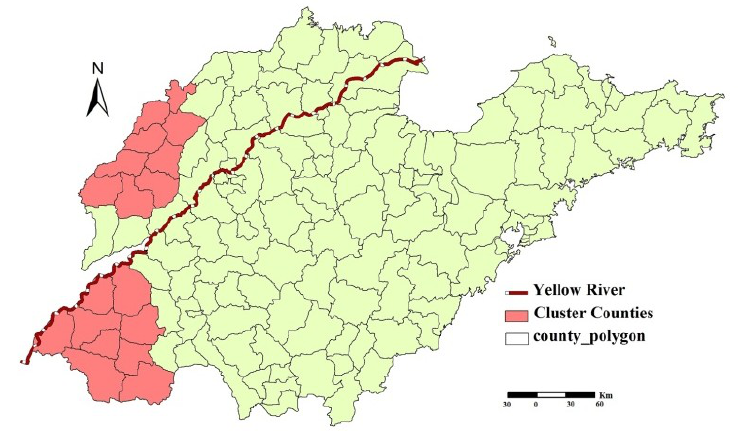
Figure 3. Spatial clusters detected by Local Moran’s I in Shandong Province,